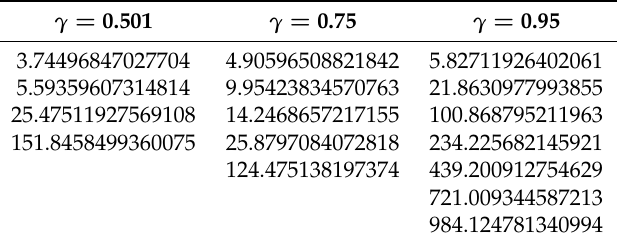
Table 2. Eigenvalues for different values of γ